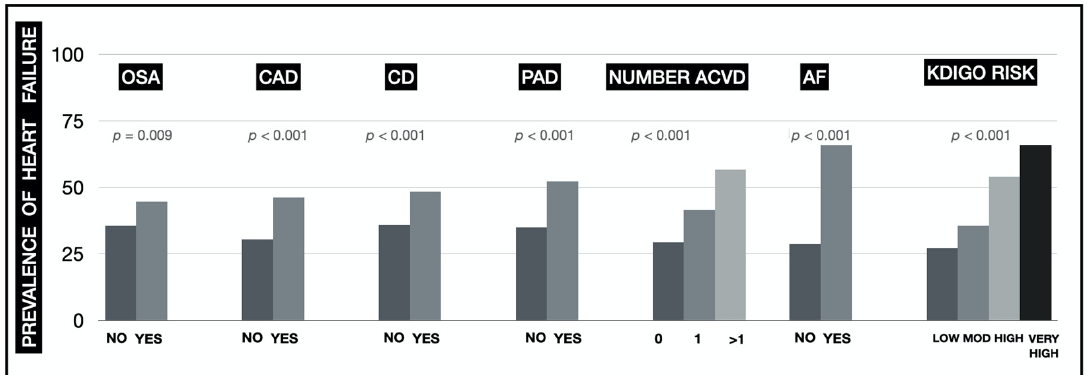
Figure 1. Prevalence of HF based on the patients’ concomitant conditions (OSA: obstructive sleep apnoea syndrome; CAD: coronary artery disease; CD: cerebrovascular disease; PAD: peripheral artery disease; ACVD: atherosclerotic cardiovascular disease; AF: atrial fibrillation; KDIGO: Kidney Disease Improving Global Outcomes).